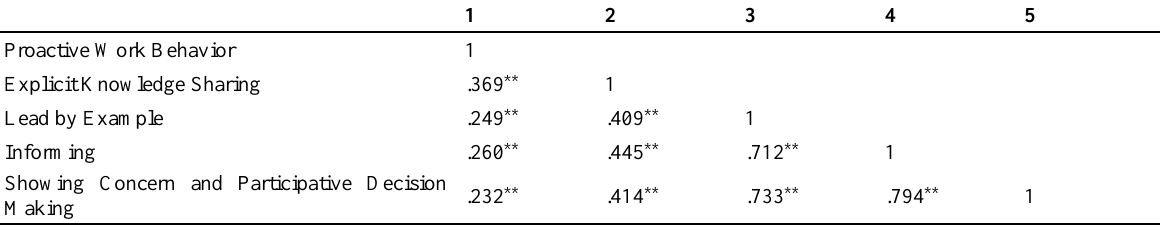
Table 2: Correlation Analysis Results